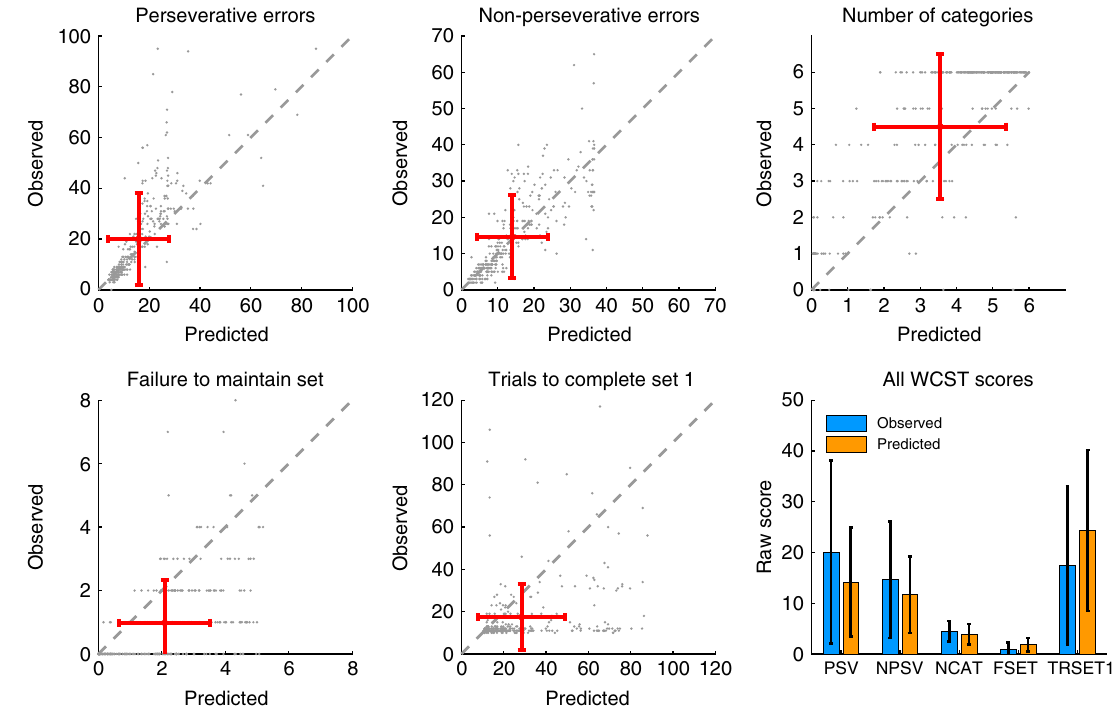
Fig. 3 Comparison of observed vs. model-predicted WCST scores (posterior predictive check). Red error bars indicate the mean of the observed and predicted WCST scores, which are also shown more conventionally in the bar plot (error bars are ±1